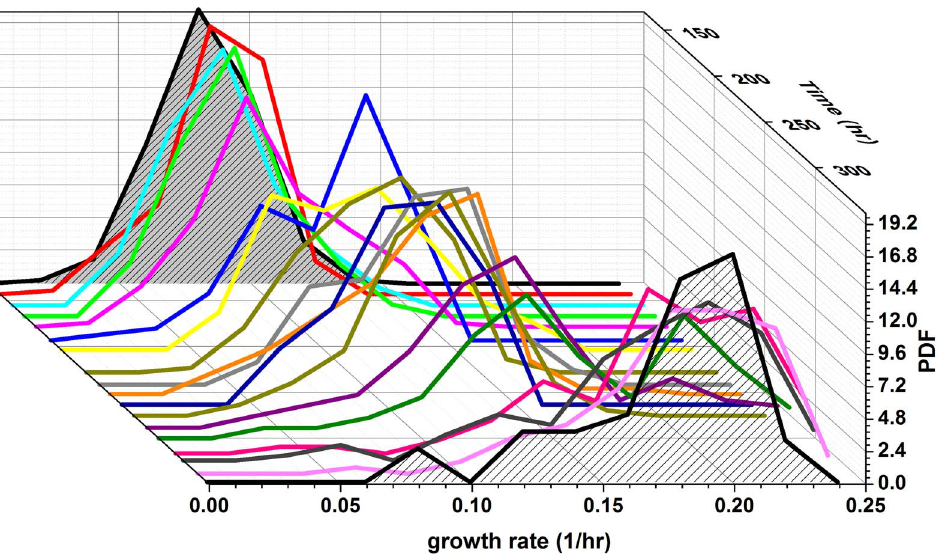
Figure 3. Single-cell, instantaneous growth-rate distributions. Histograms of the growth-rates plotted as a function of time. The instantaneous growth-rates were estimated from time-lapse microscopy measurements (Methods). The mean division time of the first distribution is 8.4 hours.